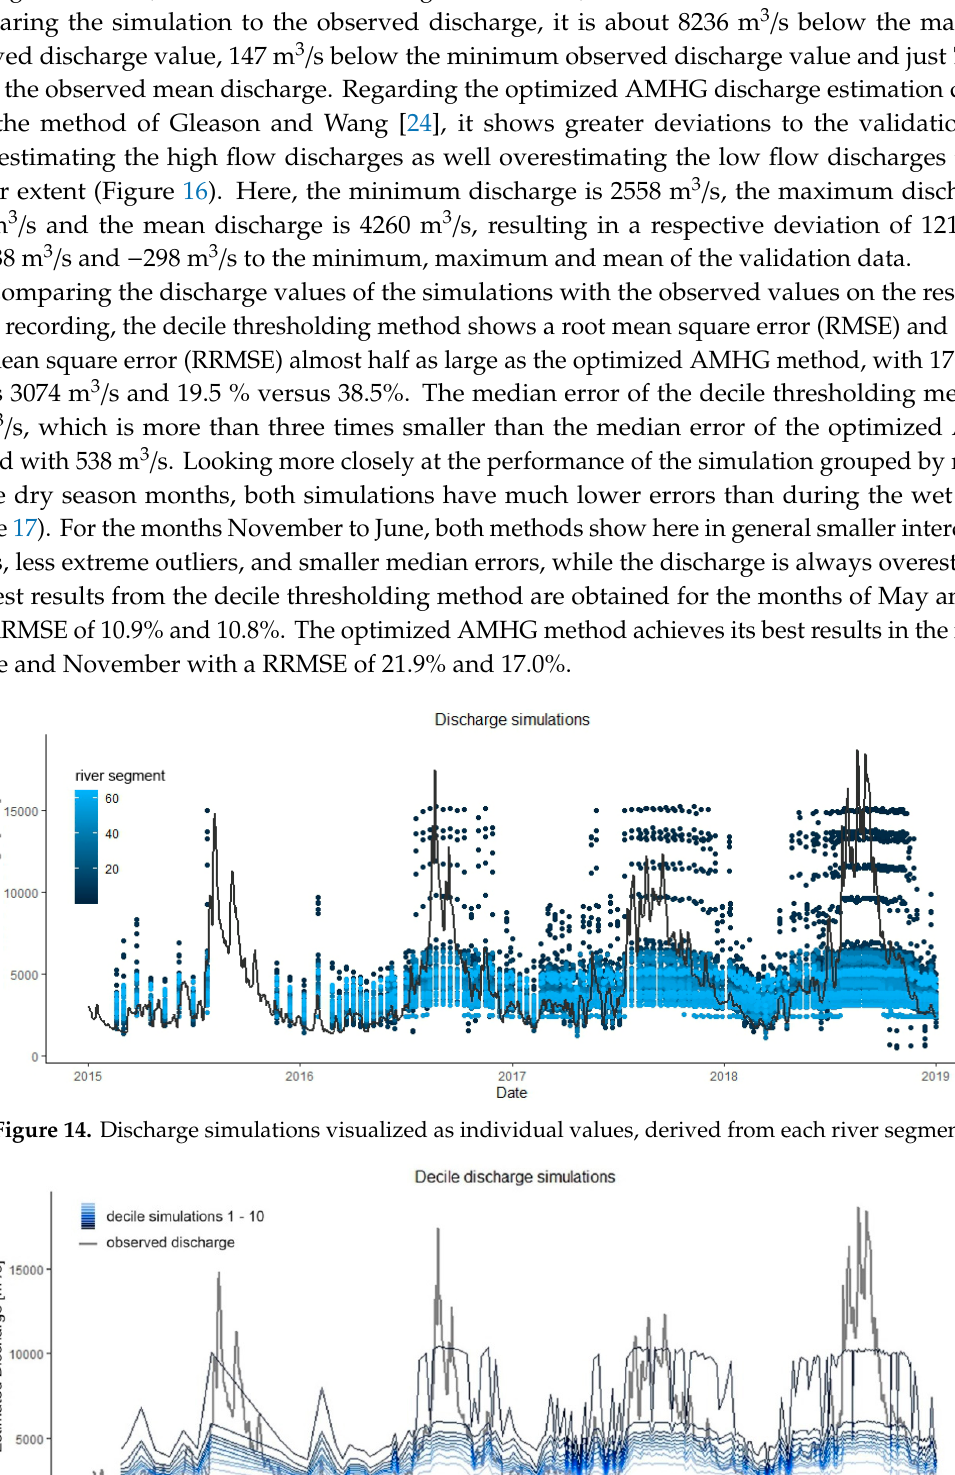
Figure 16. Final discharge estimation by decile thresholding method compared to optimized AMHG method.